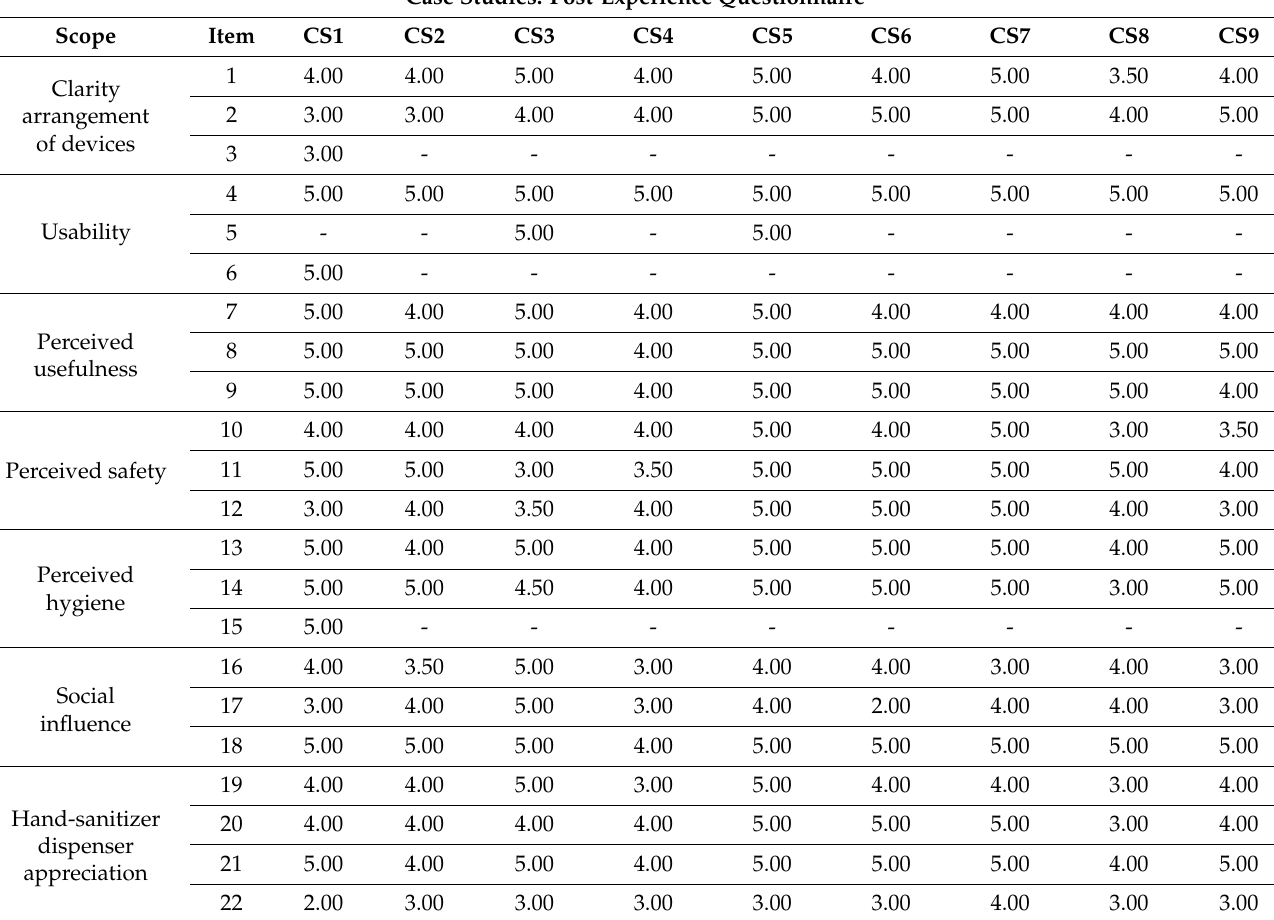
Table 11. Results (median values) of each questionnaire administered in the nine case studies, aimed at evaluating the general implementation of the anti-COVID measures and the devices used in each facility. Own